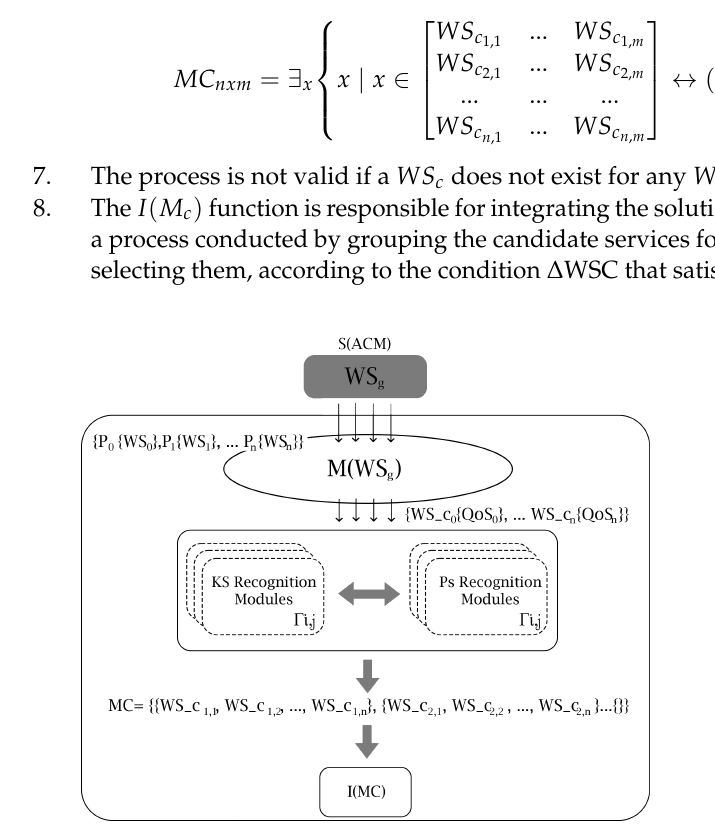
Figure 7. Ar_WSDS recognition